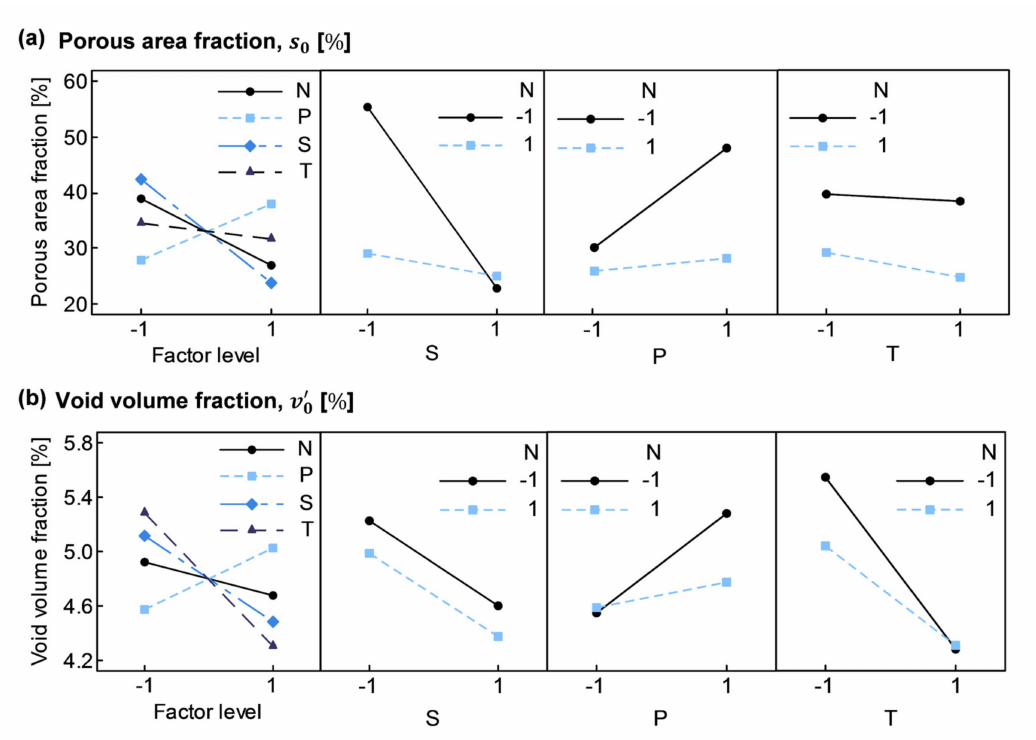
Figure 15. Effects of main factors and two-factor interactions (interaction effects are aliased according to l NS = l PT , l NP = l ST , and l NT = l SP ): ( a ) Porous area fraction, s 0 ; ( b ) Void volume fraction, v (cid:48)